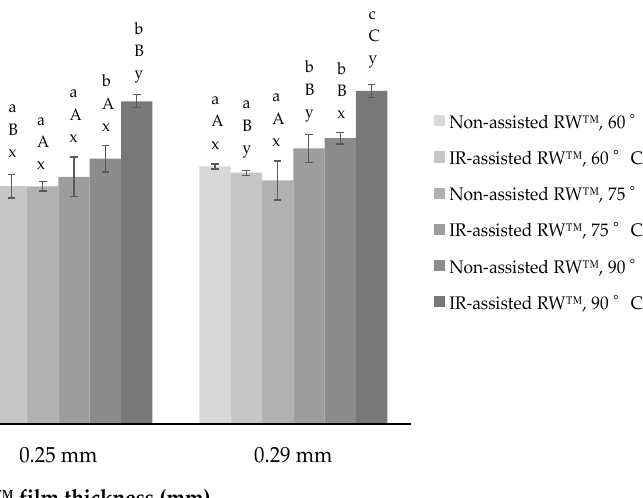
Figure 6. Color di ff erence ( ∆ E) for dried P hysalis pur é e regarding to all RW ™ drying experiments. Figure 6. Color difference ( Δ E) for dried P hysalis purée regarding to all RW™ drying experiments. Di ff erent lower case letters (a–c) indicate that there are significant di ff erences ( p -value < 0.05) between Different lower case letters (a–c) indicate that there are significant differences ( p -value < 0.05) between drying temperatures. Di ff erent upper case letters (A–C) indicate that there are significant di ff erences drying temperatures. Different upper case letters (A–C) indicate that there are significant differences ( p -value < 0.05) between thickness. Di ff erent lower case letters (x, y, z) indicate that there are significant ( p -value < 0.05) between thickness. Different lower case letters (x, y, z) indicate that there are di ff erences ( p -value < 0.05) between RW ™ drying significant differences ( p -value < 0.05) between RW™ drying method.